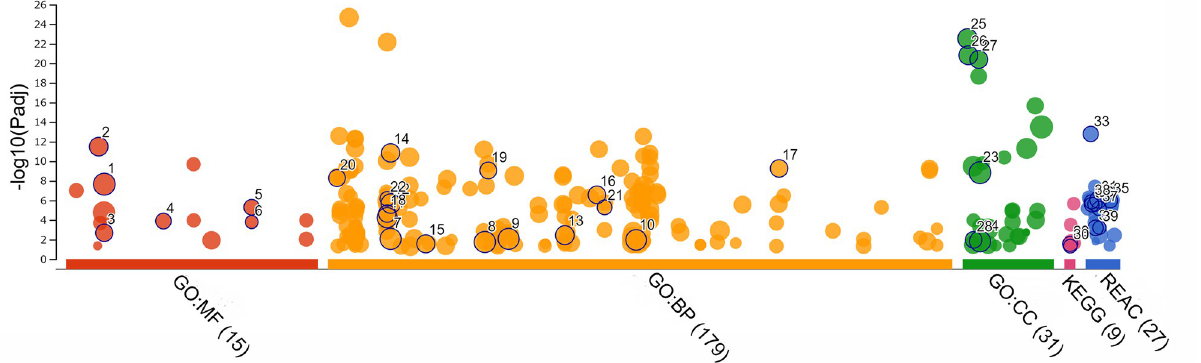
Fig 5. Pathways and gene ontology (GO) analyses using g:Profiler. Pathway and GO analyses of significantly differentially expressed genes (fold change � 2 and p � 0.05) are shown. The numbers identified in Fig 4 are further described in Table 3. (MF: molecular functions. BP: biological processes. CC: cellular components, REAC: Reactome pathway. KEGG: Kyoto Encyclopedia of Genes and Genomes pathway. n = 3 for each group).